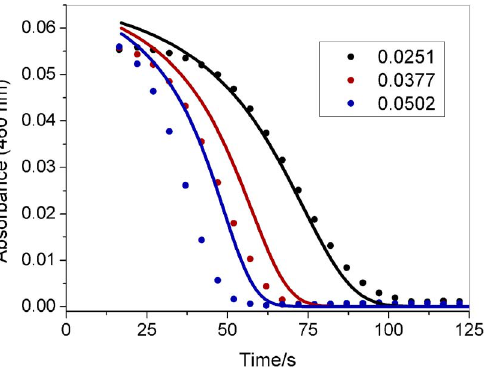
Figure 3. Effect of the chlorate concentration on the clock time. The initial concentrations after mixing the reactants in the cuvette were as follows: [NaClO 3 ] as indicated in the figure (mol L 2 1 ), [O 3 ]=3.0 6 10 2 6 mol L 2 1 , [HClO 4 ]=0,474 mol L 2 1 , [I 2 ]=8.8 6 10 2 5 mol L 2 1 . Experimental data (symbols); modeling results (continuous line).